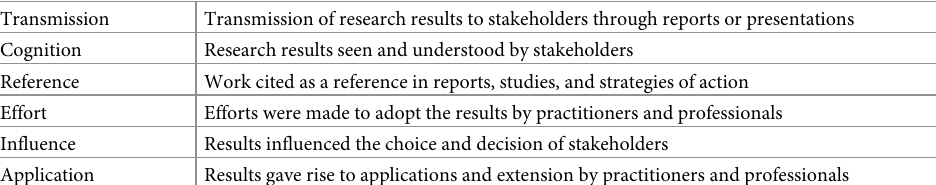
Table 1. Stages of the ladder of knowledge utilization. Adapted from